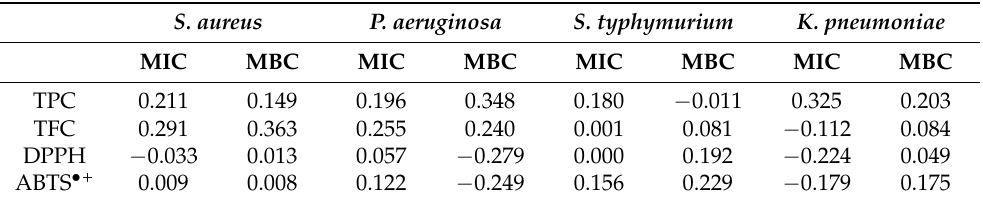
Table 4. Correlation coefficient (r) values estimated from correlation analysis of TPC, TFC, DPPH, and ABTS • + values with MIC and MBC values against four